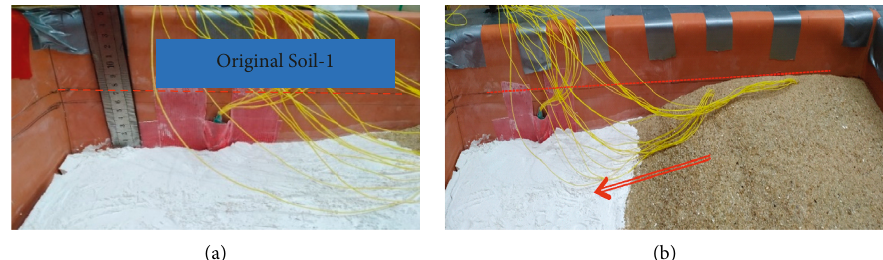
Figure 6: Surface of soils after 0.3 g seismic in the model. (a) Vertical displacement of soil-1. (b) Lateral spreading caused by seismic.